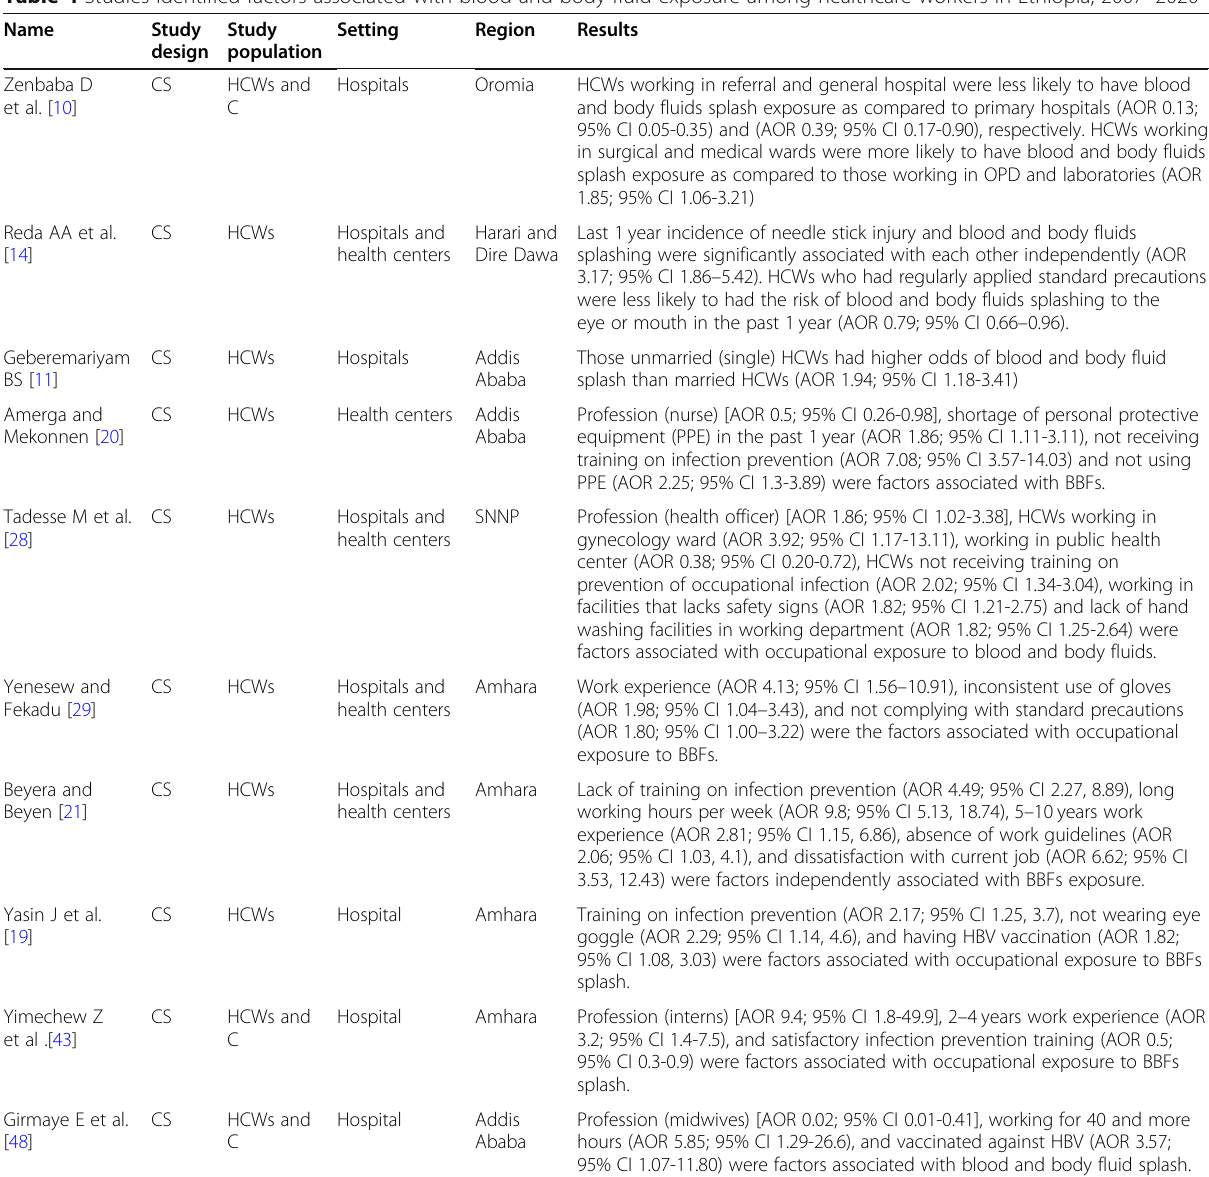
Table 4 Studies identified factors associated with blood and body fluid exposure among healthcare workers in Ethiopia, 2007 –